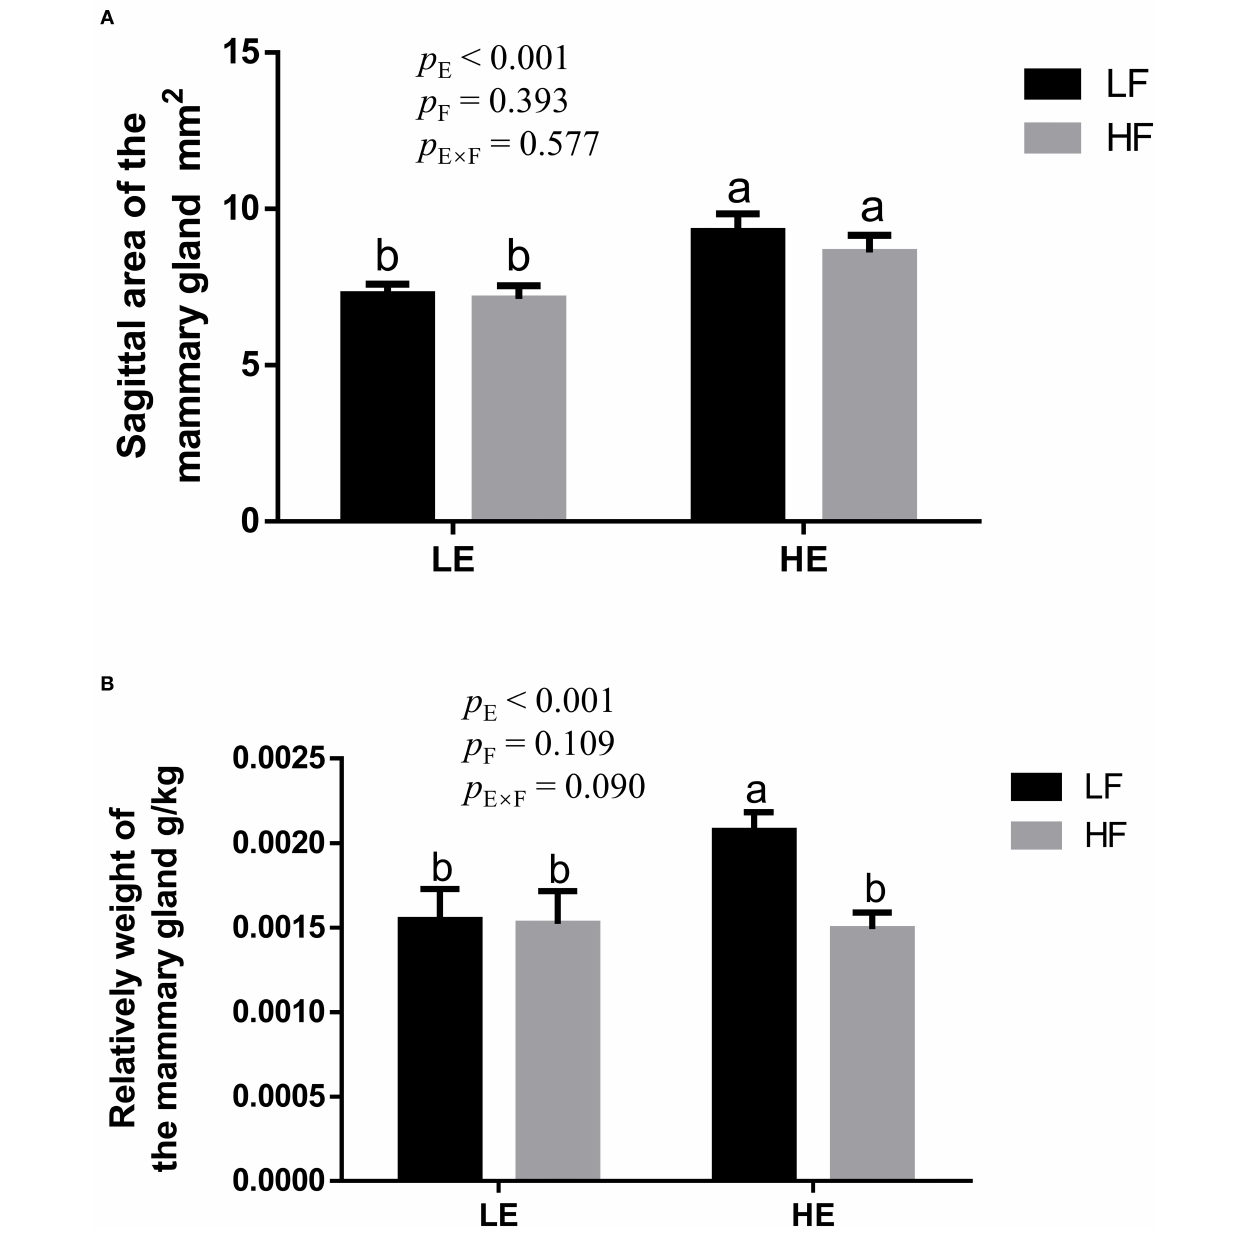
FIGURE 1 | The effect of energy and fiber interaction on the sagittal area (A) and (B) relative weight of the mammary gland of the gilts (n = 8). LELF, low-energy low-fiber group; LEHF, low-energy high-fiber group; HELF, high energy low-fiber group; HEHF, high-energy high-fiber group; E × F, energy and fiber interaction. a,b Means not sharing identical superscripts are significantly different ( p <